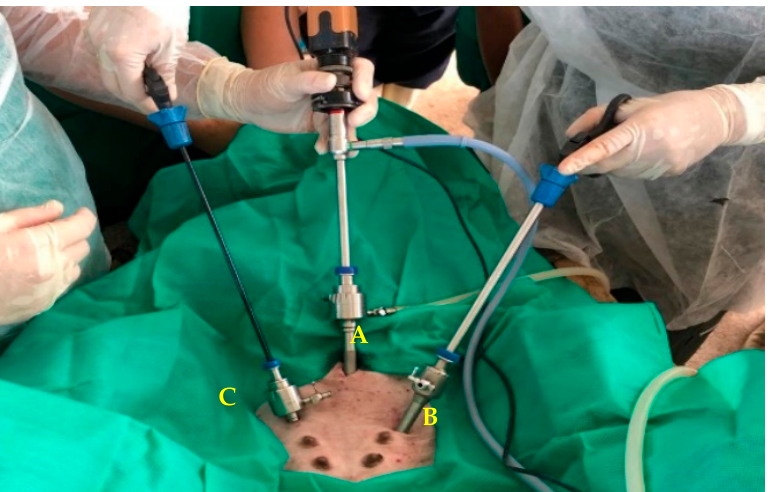
Figure 3 . Arrangement of the laparoscopic ports in the caudocranial direction, with the animal in the supine position: first port with inflation valve and rigid optics (A), second port with 10 mm forceps (B) and third port with 5 mm forceps (C).